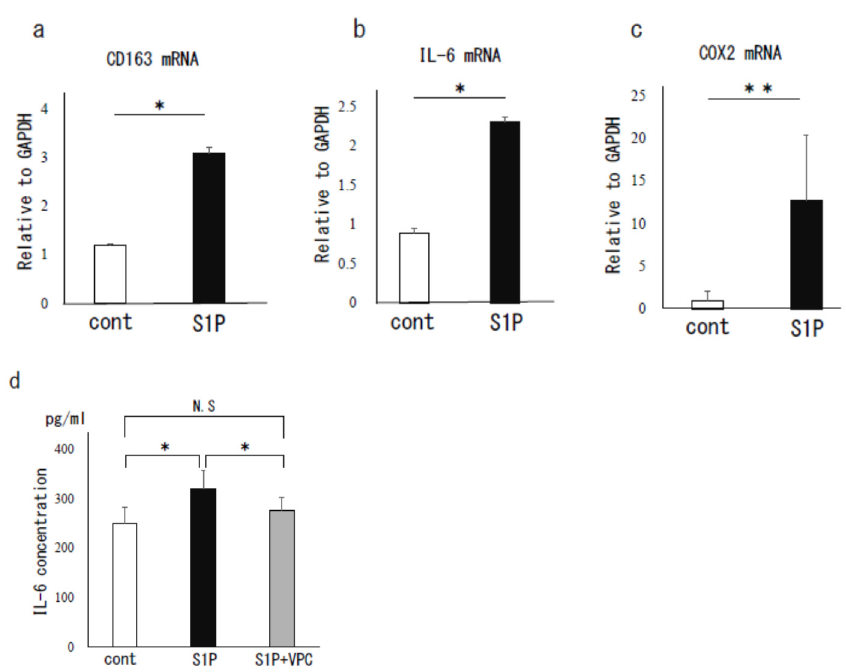
Figure 2. The S1P effect on human peritoneal macrophages (M Φ ). Peritoneal M Φ were stimulated with S1P (125 nM) for 8 h. Total RNA was extracted from the cells and subjected to real-time PCR to determine the mRNA levels of CD163 ( a ), IL-6 ( b ), and COX-2 ( c ). Data were normalized by GAPDH mRNA levels to show the relative abundance. The supernatant of peritoneal M Φ stimulated with S1P (125 nM, 24 h) was subjected for measurement of IL-6 protein by ELISA. VPC23019, an antagonist of S1P receptor (S1PR)-1 and S1PR-3, was used to antagonize the S1P effect ( d ). Data from 3 different experiments are shown as the mean ± SEM. *, p < 0.05 (vs. control); **, p < 0.01 (vs. control); N.S., not significant, cont., control.